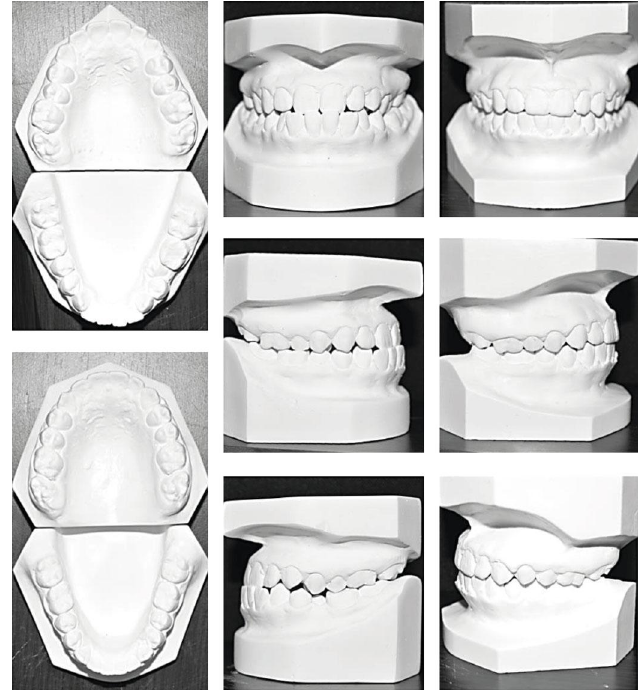
Figure 13: Initial and fi nal study